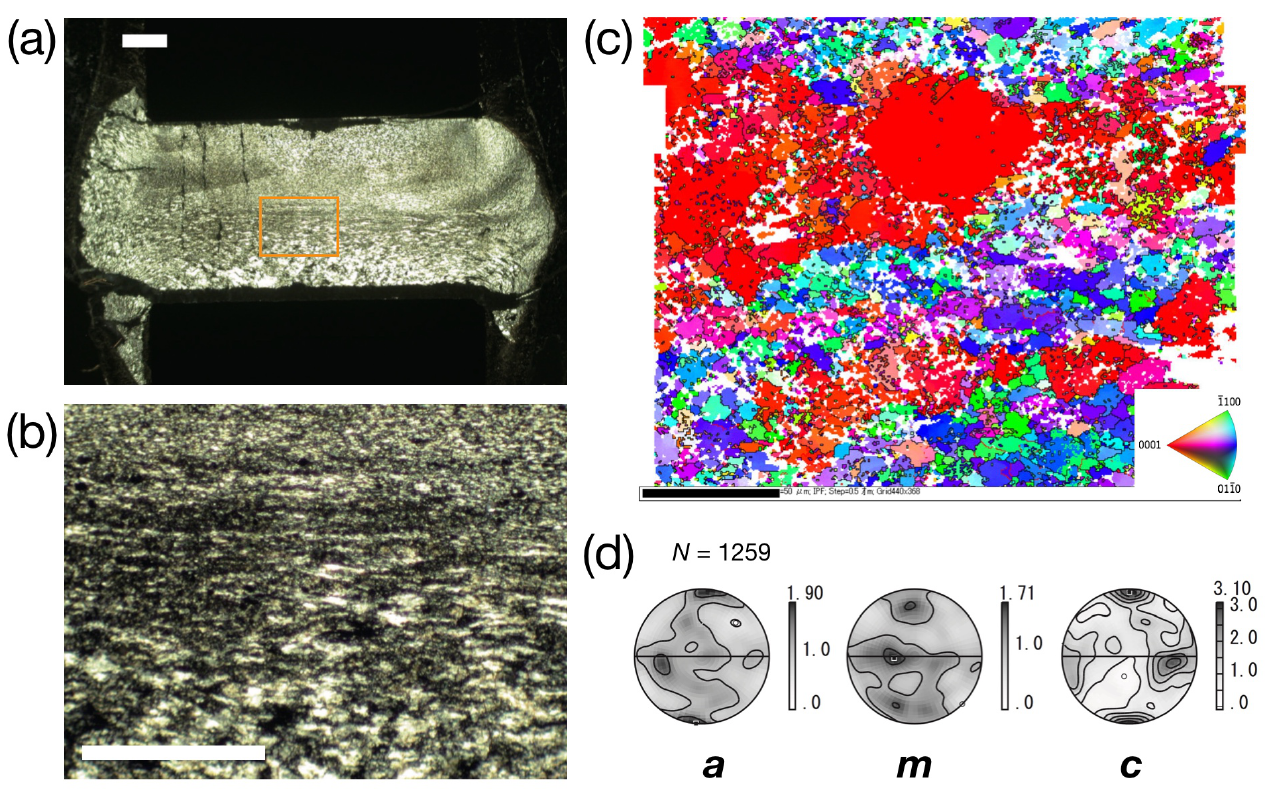
Figure 9. Microstructures of the recovered sample of the experiment (FL761229) conducted at 800 ◦ C and ˙ ε = 10 − 5 s − 1 by MF. ( a ) An optical micrograph of a thin section under crossed polarized lights. ( b ) Close up of the orange rectangular area of ( a ). Scale bars (white) are 2 mm. ( c ) An EBSD map of FL761229. The c -axes of red grains are oriented vertically, whereas those of blue- to green grains are oriented horizontally. See the inverse pole figure for coloring of the crystal orientation with respect to the cylinder axis. Crystallographic orientations of blank pixels (white) were not indexed. Most black lines within the large red grains are pseudo-symmetric boundaries that were misindexed as Dauphiné twins. Scale bar is 50 µ m. The step size is 0.5 µ m. ( d ) Pole figures of crystallographic direction/pole of a (cid:104) 11¯20 (cid:105) , m (10¯10), and c [0001]. The horizontal lines are parallel to the basal planes of the cylindrical samples. N is the total number of measurements. Compression direction is vertical for all